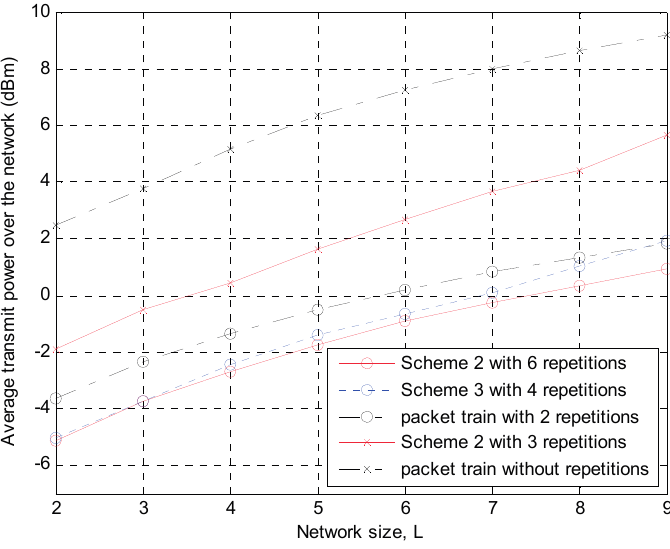
Figure 15. Average transmit power over the network depending on the number of nodes or the network